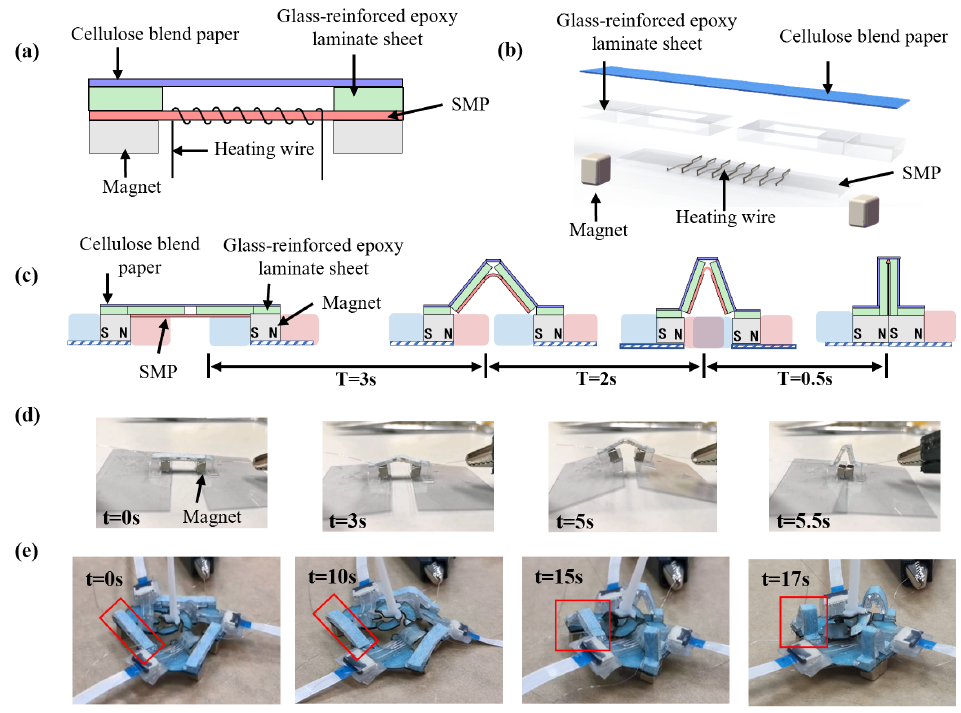
Figure 5. Design of millimeter-scale self-folding technique. ( a ) Structural composition of a single self-folding unit. ( b ) Structural exploded view of a single self-folding unit. ( c ) Schematic diagram of the self-folding process. T indicates the time required for the transition period. ( d ) Photos of the self-folding process. ( e ) Photos of the self-folding process of the miniature soft sensor. The red rectangle shows the movement process of one self-folding unit. See Video S1 for more